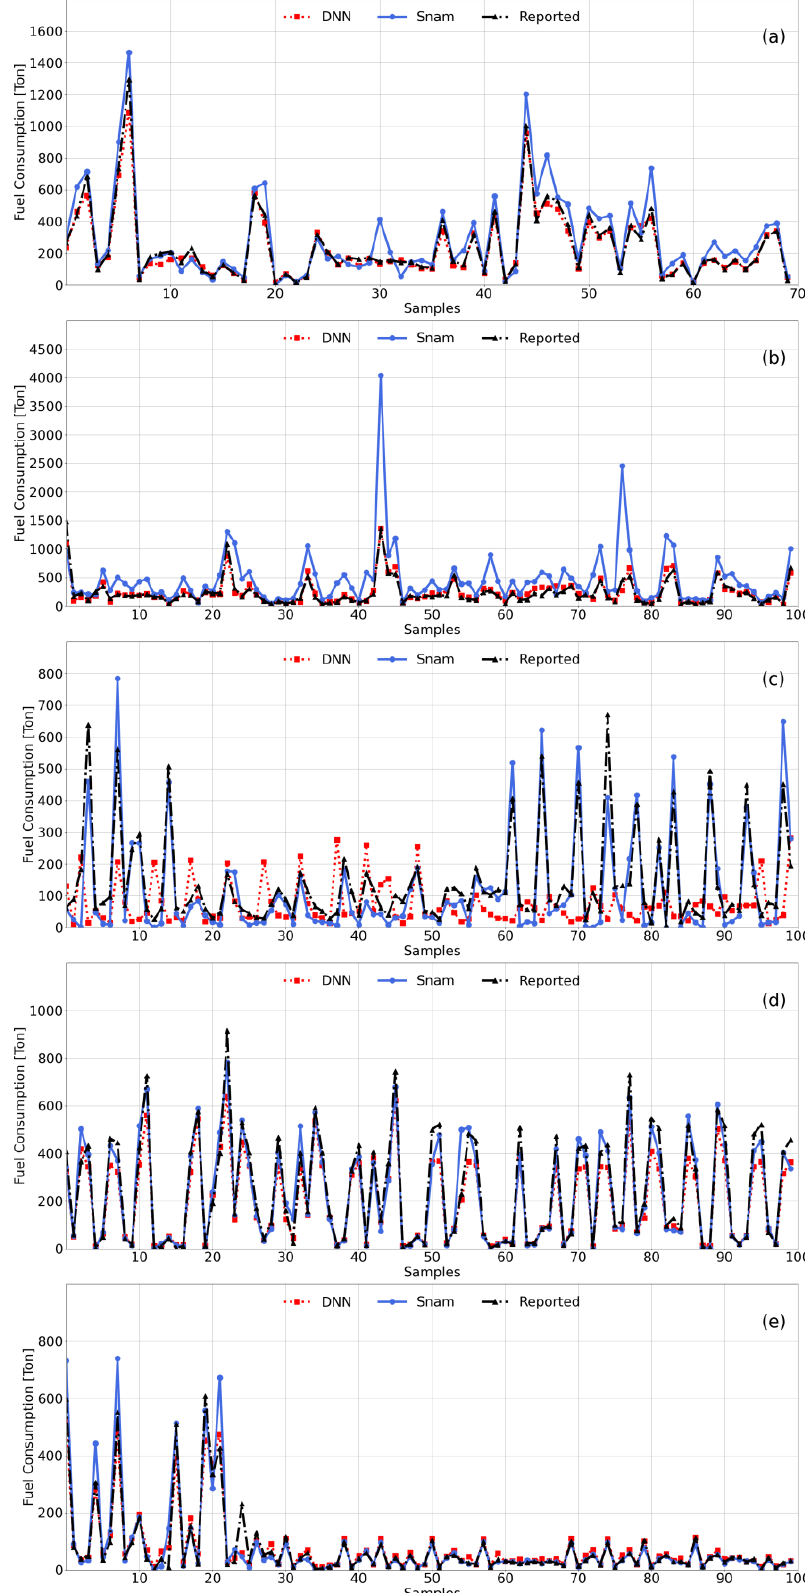
Figure 3. Fuel consumption of bulk carriers ( a ), oil tankers ( b ), containerships ( c ), general cargo ships ( d ), and RoRo ships ( e ).